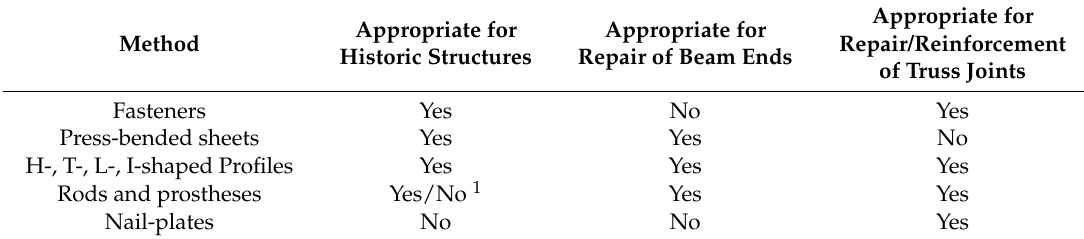
Table 2. Repair methods using stainless steel elements.